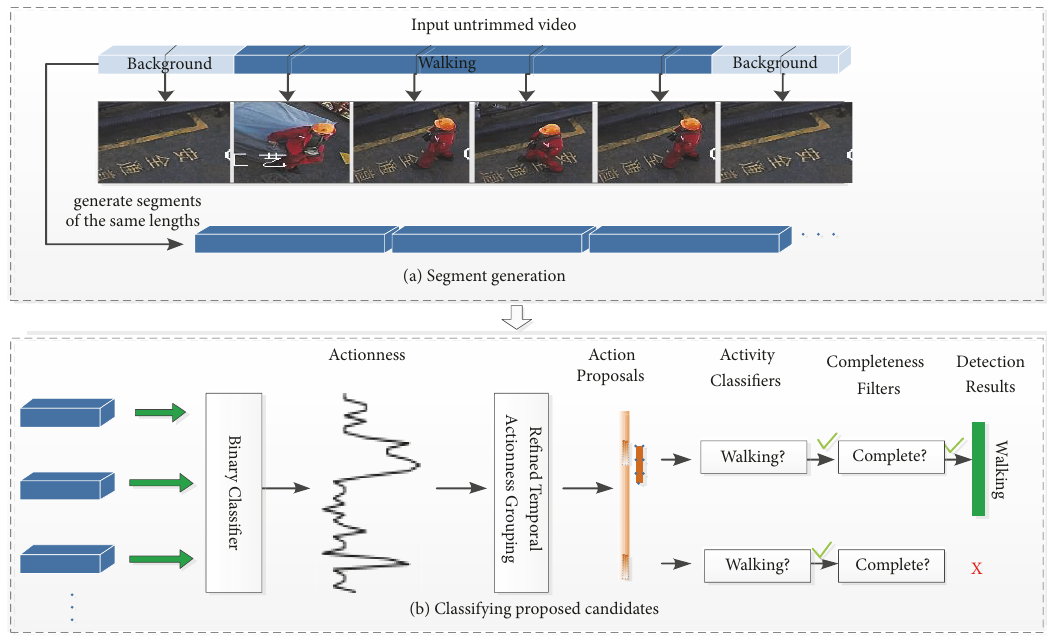
Figure 1: An overview of the proposed